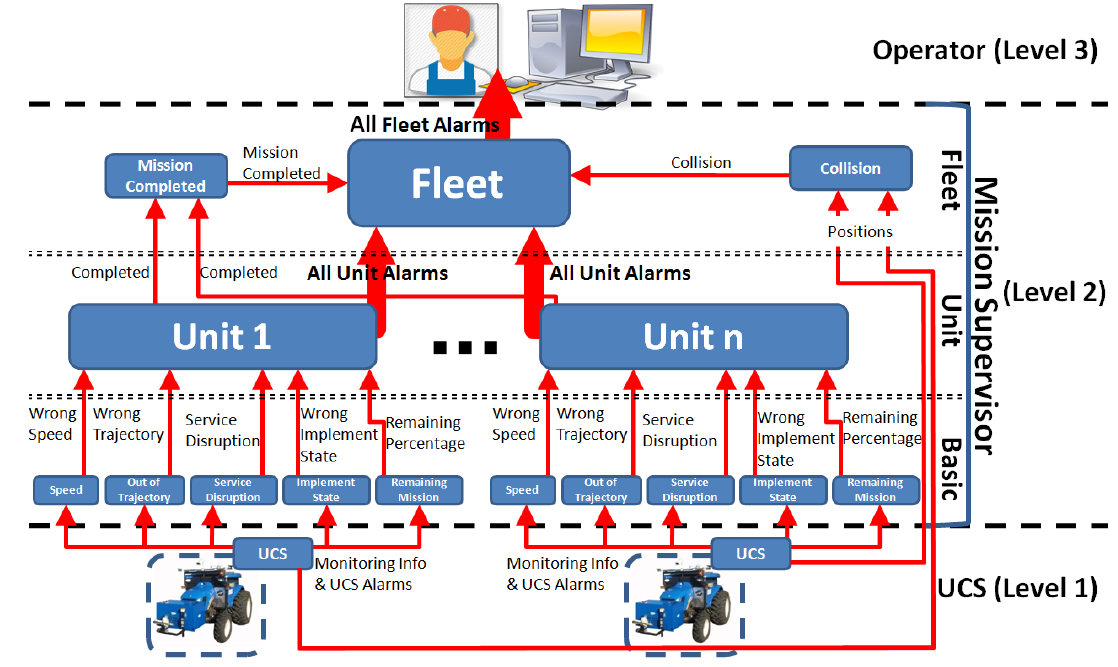
Figure 2. Supervision architecture. The rounded rectangles represent supervisors at different levels, and the arrows represent their inputs and outputs, alarms and monitoring